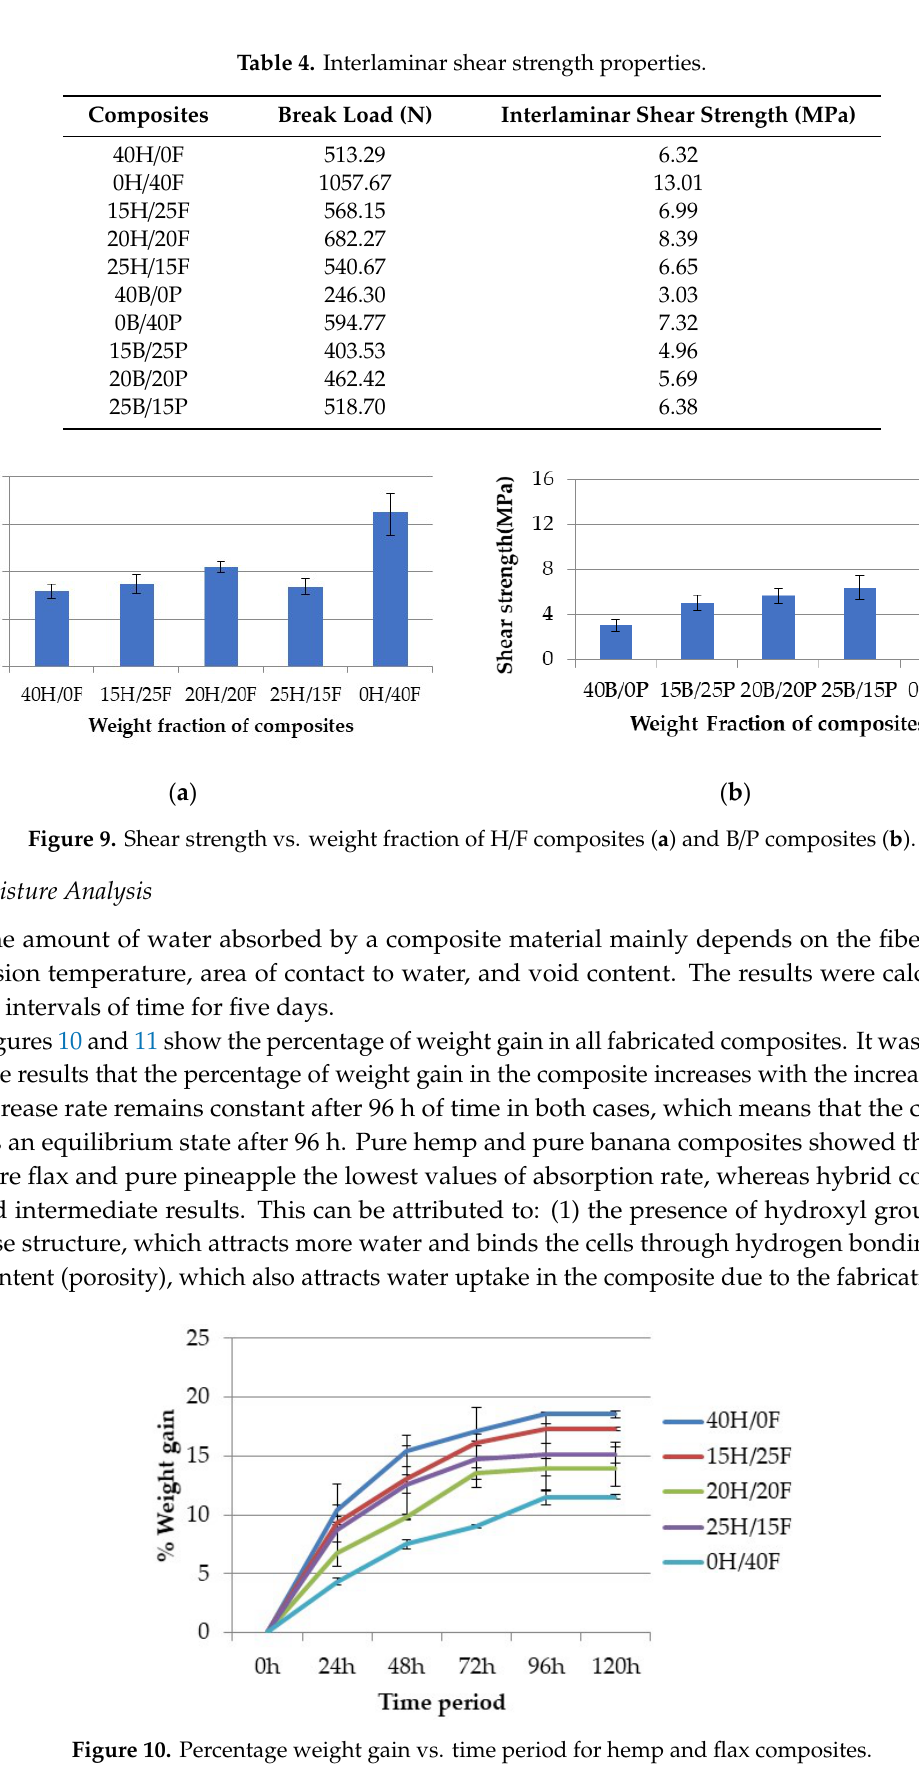
Table 4. Interlaminar shear strength properties.